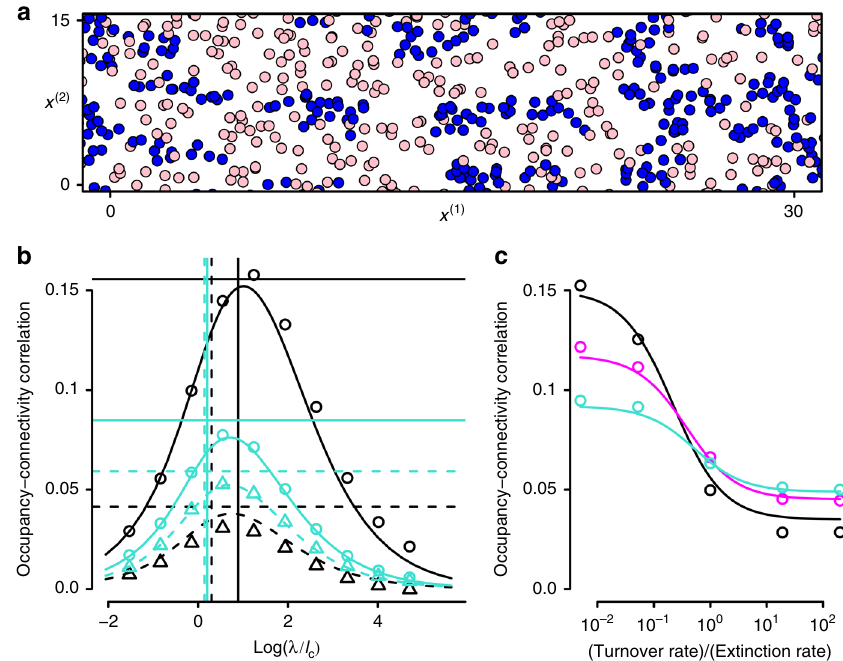
Fig. 3 Occupancy – connectivity correlation in the dynamic landscape metapopulation. The model is de fi ned in Fig. 2b. Snapshot a illustrates that patches are more likely to be occupied (blue symbols) rather than unoccupied (pink symbols) when they are close to other patches b . Connectivity – occupancy correlation depends strongly on the ratio of the length scale λ of the connectivity kernel to the length scale l of the colonisation kernel. Lines show c analytical predictions and symbols are simulation results. Colonisation and connectivity kernels are chosen to have the same standard deviation when λ ¼ l . The highest correlation occurs when λ is 3 – 4 times larger that l . The optimal length scale depends only weakly on whether the landscape is static c c (solid lines, circles) or dynamic (dashed lines, triangles), or whether occupancy P 0 is high ( P 0 ¼ 0 : 667, cyan) or low ( P 0 ¼ 0 : 167, black). The correlation for the exponential connectivity kernel with the optimal choice of length scale is within 10 – 20% of the horizontal lines, which represent the occupancy – connectivity correlation for the optimal connectivity kernel shape ~ h ? . The choice λ ¼ λ (vertical lines), where the connectivity kernel has the (cid:4) same standard deviation as the optimal connectivity kernel h , gives a higher occupancy – connectivity correlation than λ ¼ l . c Occupancy – connectivity (cid:4) c correlation decreases when rate of patch turnover μ increases relative to patch extinction rate e . Lines are analytical approximation, and symbols are the results of simulations. Parameters r and μ are chosen so that patch density = 1 and mean- fi eld occupancy P 0 is kept constant as μ = e changes; colour denotes P 0 ¼ 0 : 167 (black); P 0 ¼ 0 : 333 (magenta); P 0 ¼ 0 : 667 (cyan). Error bars not shown as standard errors are smaller than the plotting symbols. Parameter values and kernels are given in the Methods